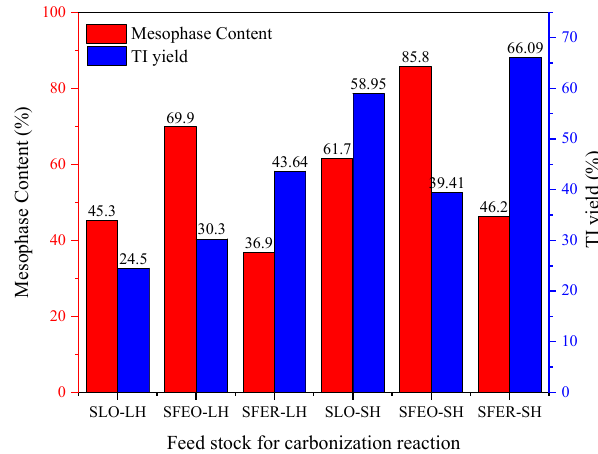
Figure 15. The diagram of TI yield and mesophase content.